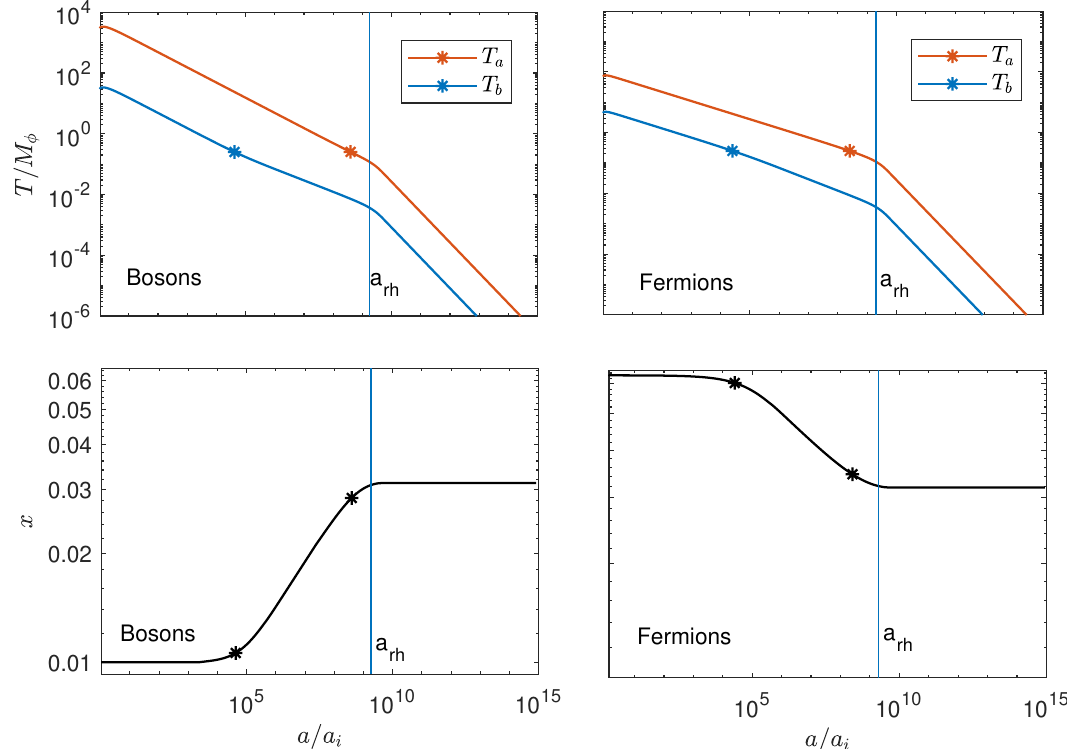
Figure 2. Upper panels: radiation temperature as a function of scale factor for two-sector re- heating without scattering, when the in(cid:13)aton decays to particles with the same statistics in both sectors. The upper left panel shows results for an in(cid:13)aton coupled to bosons in both sectors with (cid:0) 0 ;a = 10 (cid:0) 14 M (cid:30) (red) and (cid:0) 0 ;b = 10 (cid:0) 20 M (cid:30) (blue); the upper right panel shows the same for in- (cid:13)aton decays to fermions. Other parameters are speci(cid:12)ed in eq. (3.3). Reheating is indicated by the vertical blue line at a rh . Lower panels: temperature ratio of the two sectors, x = T b =T a , as a function of the scale factor. In each panel, asterisks indicate T b = M (cid:30) = 4 (left) and T a = M (cid:30) = 4 (right), which is approximately where quantum statistics become unimportant in each sector. The left panel corresponds to bosons in both sectors, while the right panel corresponds to fermions in both